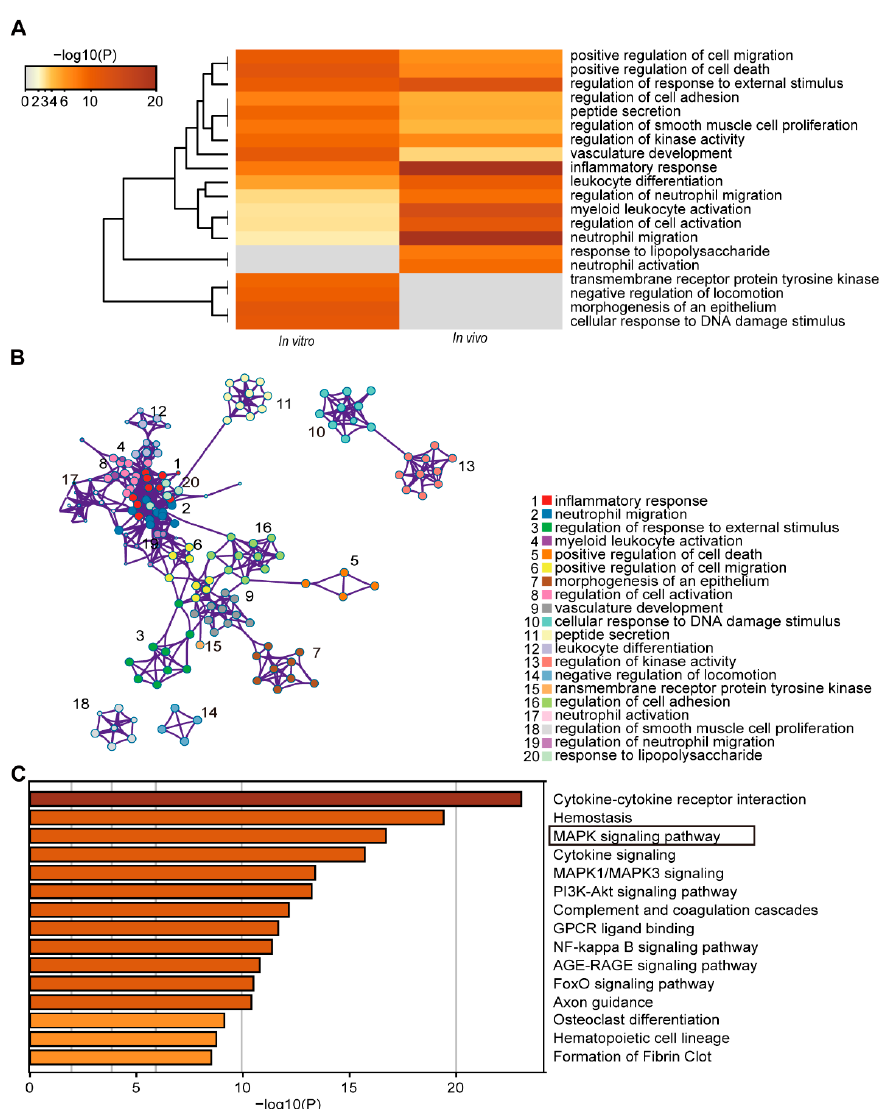
Figure 4. The GO analysis of PD-induced DEGs in C2C12 cells and mouse quadricep muscles. ( A ) GO biological processes of DEGs using Metascape. ( B ) Network of GO biological processes of DEGs. Each term was represented by a circle node, where its size was proportional to the number of genes falling into that term; nodes of the same color belonged to the same cluster, and an edge linked terms with a similarity score > 0.3; the thickness of the edge represented the similarity score. ( C ) KEGG enriched pathways of the DEGs in 14 coregulated clusters related to inflammation, cell death, and immunity, by